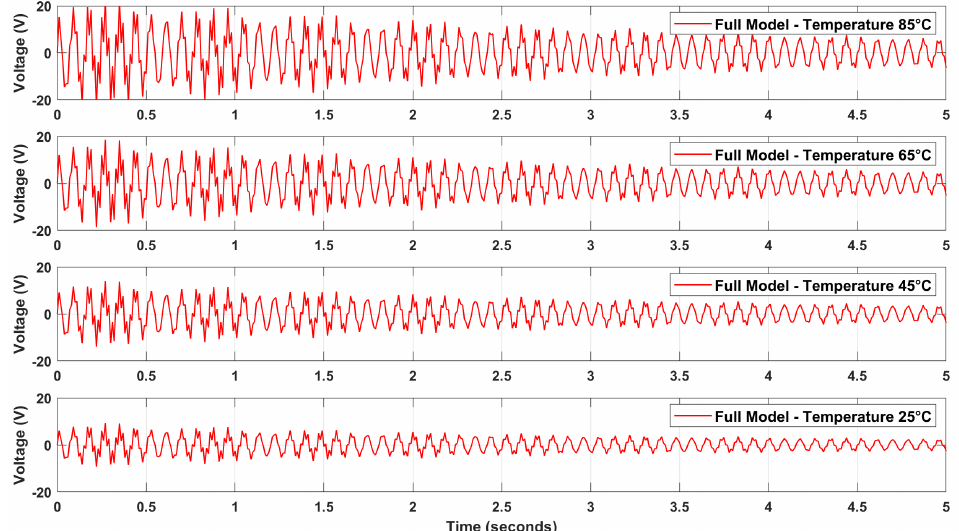
Figure 10. Sensor output voltage using LQG-Kalman control for full model for multiple temperatures with 5 distributed pairs of sensor/actuator and 10 selected sensor